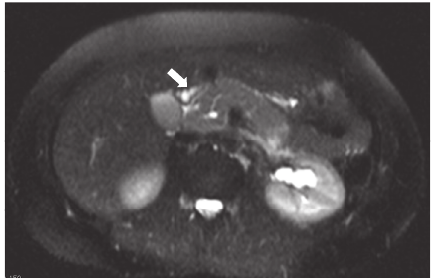
Figure 2: Magnetic resonance image of the abdomen with contrast (T2 sequence) shows heterogeneous signal pancreatic head mass measuring 4.5 cm, triggering concern for primary pancreatic carci- noma with associated pancreatic duct dilatation and peripancreatic lymphadenopathy (white